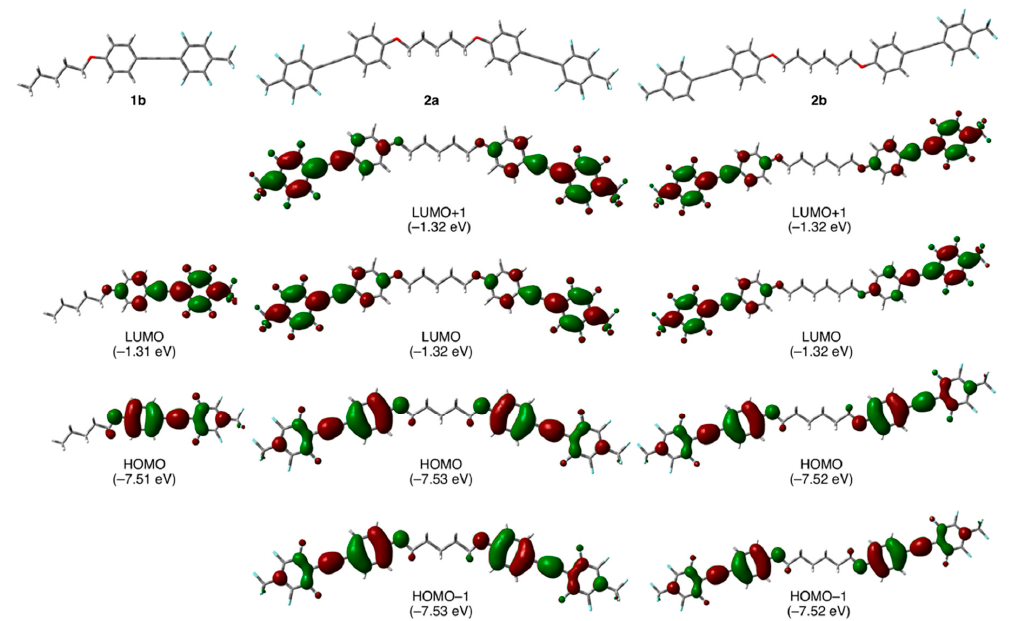
Figure 2. Optimized geometries of 1b , 2a , and 2b and their molecular orbital distributions (orbital energy) involving vertical electronic transitions obtained by theoretical chemical calculations at the CAM-B3LYP/6-31+G(d) level of theory.